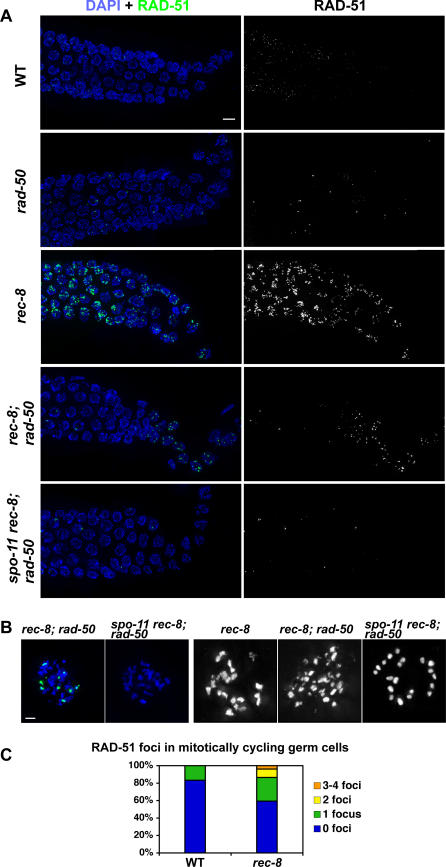
DSB Formation and RAD-51 Loading in the rec-8 Mutant Background(A) Images show portions of the germ lines extending from mid-late pachytene through diplotene from worms of the indicated genotypes (these worms were NOT exposed to IR). Persistent high levels of meiotic RAD-51 foci are observed throughout this region in the rec-8 single mutant [full genotype: rec-8(ok978) dpy-4(e1166)]. In the rec-8; rad-50 double mutant [full genotype: rec-8(ok978) dpy-4(e1166); rad-50(ok197)], a region in which most nuclei lack RAD-51 foci (left) is followed by a region in which most nuclei have multiple RAD-51 foci. The transition between these states in the unirradiated rec-8; rad-50 gonad occurs at the very end of the pachytene region. This late pachytene rise in RAD-51 foci is absent in the spo-11 rec-8; rad-50 triple mutant [full genotype: spo-11(me44) rec-8(ok978) dpy-4(e1166); rad-50(ok197)], implying that these late foci are SPO-11-dependent.(B) Each panel shows the full karyotype in a single oocyte nucleus of the indicated genotype, either at the late diplotene/early diakinesis stage (left two panels, stained with DAPI [blue] and RAD-51 antibody [green]) or at late diakinesis (stained with DAPI in white; images shown are from the most mature oocyte in the gonad arm, in the −1 position immediately adjacent to the spermatheca). Multiple RAD-51 foci are detected in the late diplotene/early diakinesis nucleus from the rec-8; rad-50 worm, whereas the spo-11 rec-8; rad-50 nucleus at the same stage lacks RAD-51 foci. Similarly, multiple chromosome fragments are evident in the late diakinesis nucleus from the rec-8; rad-50 worm, whereas such fragments are not detected in the spo-11 rec-8; rad-50 late diakinesis nucleus (in which chromosomes are present largely as prematurely resolving pairs of sister chromatids). Scale bar = 2 μm.(C) Elevated levels of premeiotic RAD-51 foci in rec-8 mutant germ lines. RAD-51 foci were quantified for nuclei within the first 15 rows of germ cells, beginning at the distal tip of the gonad; three different germ lines were scored for each genotype (185 total nuclei for wild type, 177 total nuclei for rec-8). Stacked bar graph depicts the percentages of nuclei scored that had the indicated numbers of RAD-51 foci; the difference between rec-8 and wild type germ lines is extremely significant (p < 0.0001).